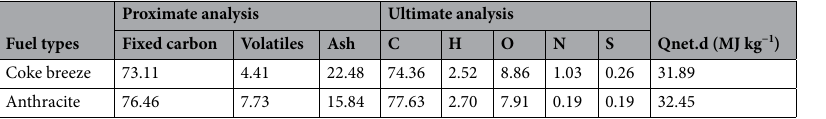
Table 3. Proximate analysis, ultimate analysis, and heating values of the fuels (mass%, MJ kg −1